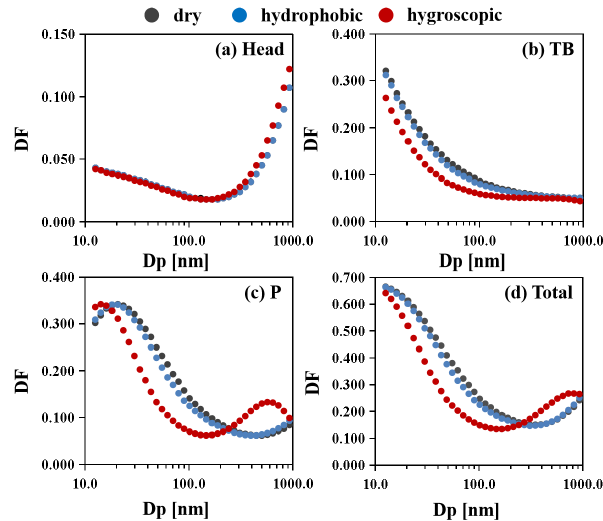
Figure 2. Size-resolved (a) head, (b) TB, (c) P, and (d) total depo- sition fractions (DFs) of particles under dry conditions (i.e., without considering hygroscopicity) and hydrophobic and hygroscopic par- ticles in humid environments (i.e., considering hygroscopicity) for the adult group. For clarity, the abscissa of Fig. 2 refers to the dry diameter of particles. The black, blue, and red dots represent dry, hydrophobic, and hygroscopic particles, respectively. In Fig. 2a, the black dots representing DFs under dry conditions are hidden be- hind the blue dots representing DFs of hydrophobic particles be- cause these two sets of DFs are close to each